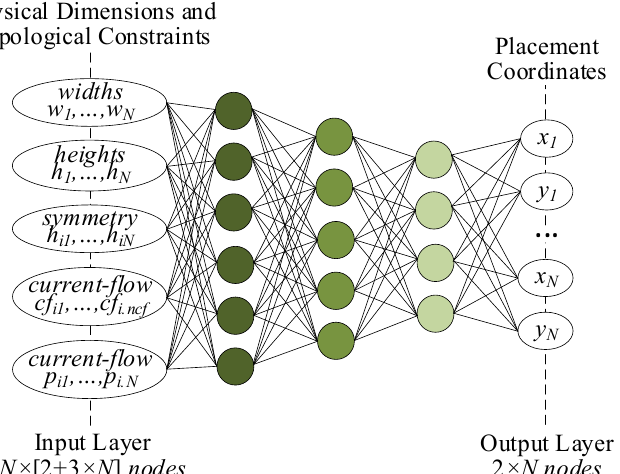
Figure 2. ANN architecture that is used to solve the map from the physical dimensions and topologi- cal constraints to the placement